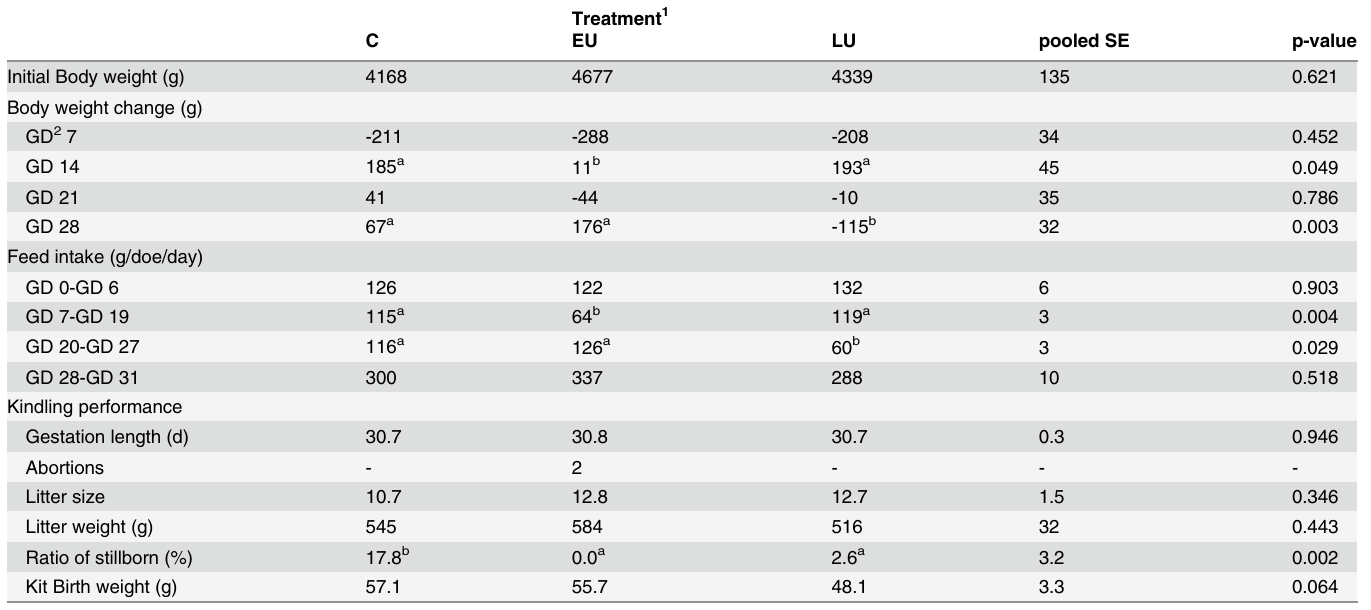
Table 2. Effect of gestational undernutrition on body weight change (g), feed intake (g/doe/day) and kindling performance of does (n =